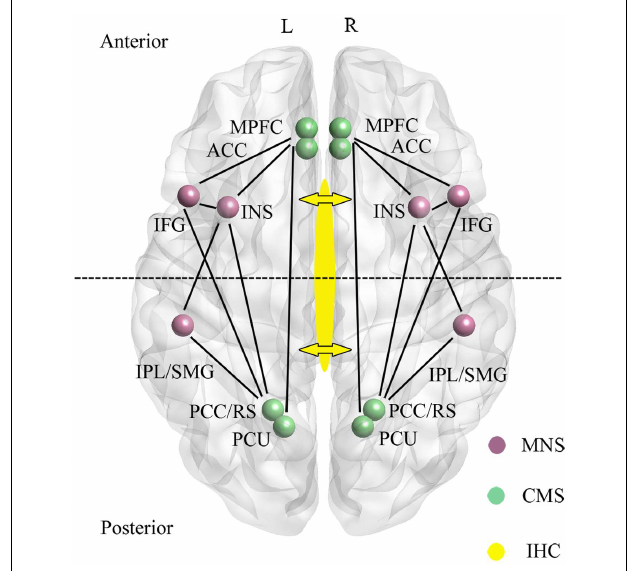
FIGURE 1 | Main regions and functional connections of the cortical midline (CMS) and mirror neuron (MNS) systems implicated in the control of self-processing . Inter-hemispheric connectivity (IHC) via the anterior and middle/posterior corpus callosum are indicated by arrows with the dotted line across the two hemispheres sub-dividing the brain into anterior frontal regions interconnected via the anterior corpus callosum and posterior parietal regions interconnected via the middle/posterior corpus callosum. ACC, anterior cingulate; IFG, inferior frontal gyrus; INS, insula; IPL, inferior parietal lobule; mPFC, medial prefrontal cortex; PCC, posterior cingulate cortex; PCU, precuneus; RS, retrosplenial cortex; SMG, supramarginal gyrus. For simplicity the anterior (mPFC and ACC) and posterior (PCC/RS and PCU) are displayed as single regions. L, left and R, right